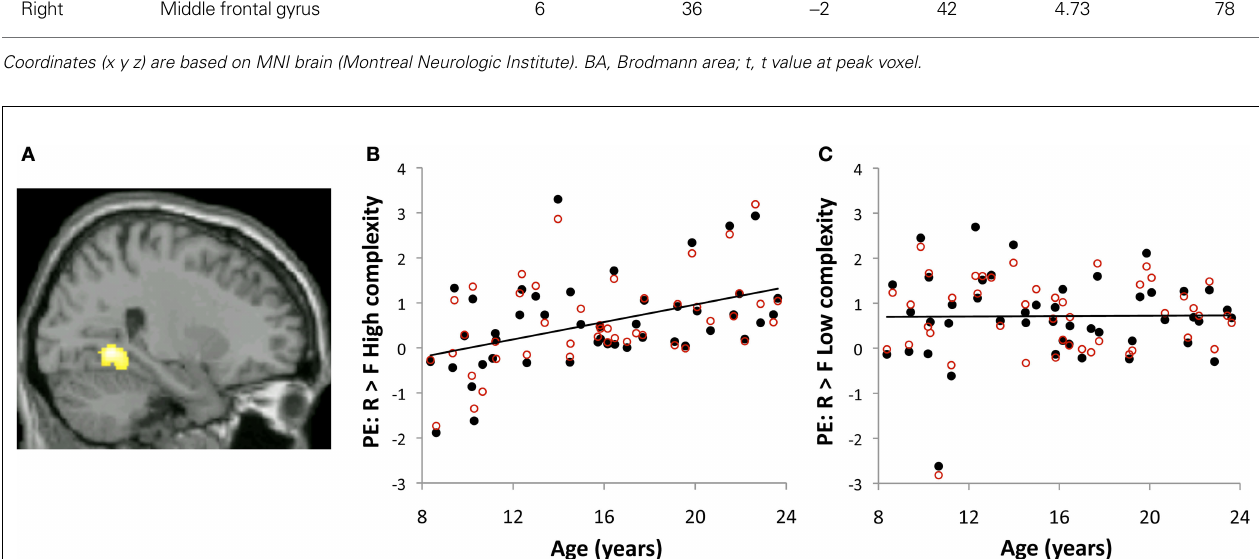
individual parameter estimates (PE) in the contrast R > F for high- (B) and low- (C) complexity scenes (black, fi lled circles). Overlaid in red (open circles) are the individual parameter estimates extracted from contrasts R > F for high- (B) and low- (C) complexity scenes after correcting for the scene’s spatial